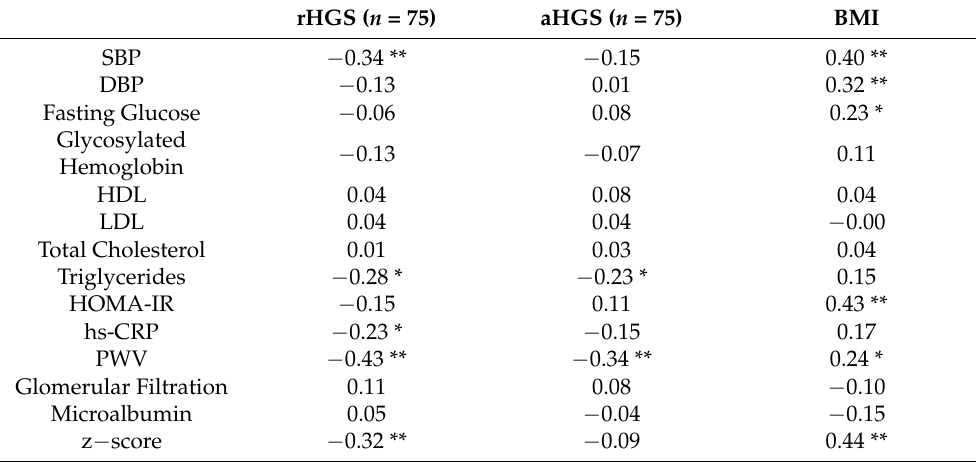
Table 2. Pearson’s bivariate correlations analysis evaluating the raw association between relative handgrip strength, absolute handgrip strength and body mass index with cardiometabolic risk components in women with systemic lupus erythematosus.